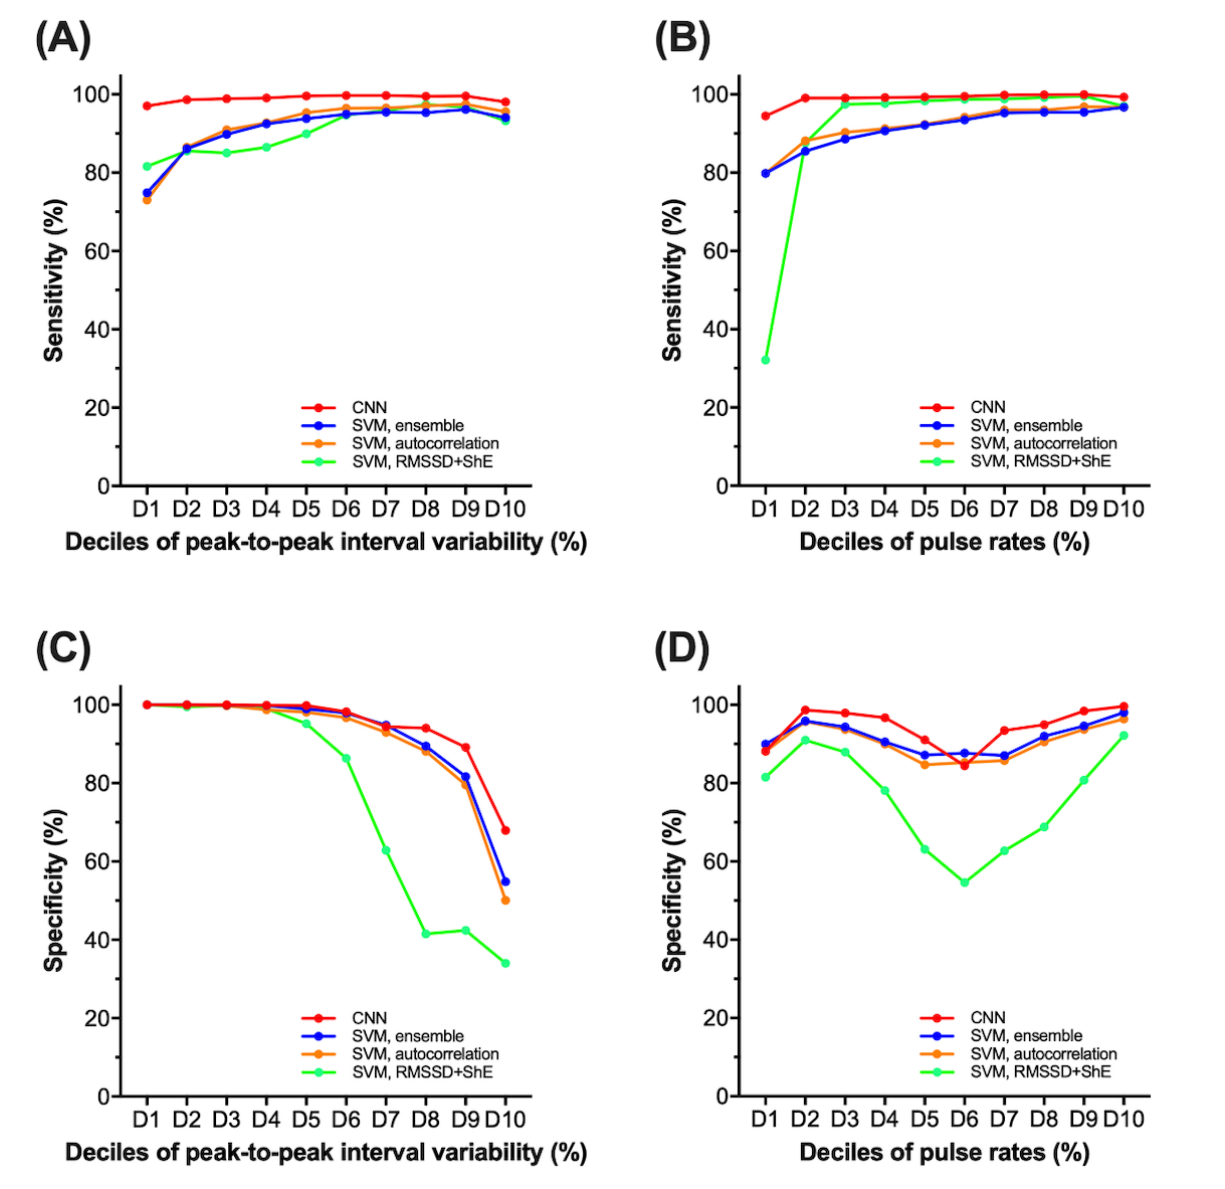
Figure 5. The sensitivity and specificity of CardioTracker according to the characteristics of samples. (A) and (B) With the deep learning algorithm, there were no definite associations between the sensitivity and peak-to-peak interval variability or the pulse rate. (C) The specificity generally decreased with higher peak-to-peak interval variability. (D) There was generally a U-shape association between specificity and the pulse rate. CNN: convolutional neural network, SVM, autocorrelation: support vector machine with autocorrelation as a feature, SVM, RMSSD+ShE: support vector machine with root mean square of the successive differences of RR intervals and Shannon entropy as features, SVM, ensemble: support vector machine with all three